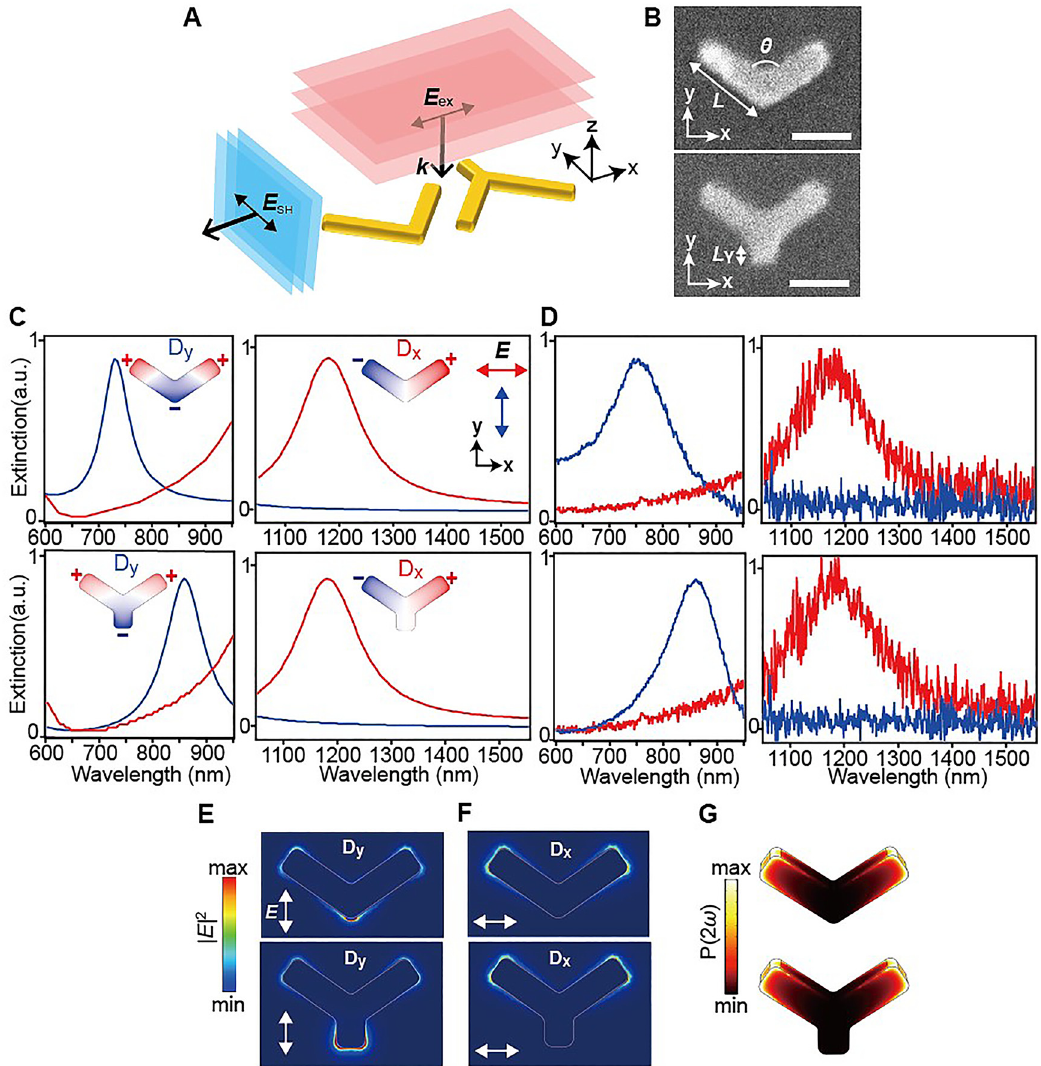
Figure 1: Characteristics of V- and Y-shaped elements in a directional second-harmonic (SH) gold nanoantenna. (A) Unidirectional SH emission from a nanoantenna. (B) SEM images of the V- and Y-elements with arm length L = 140 nm, opening angle L θ = 110 ° , and tail length L Y = 30 nm ( Y = 0 for the V-element). The scale bar is 100 nm. (C and D) Calculated and measured extinction spectra, respectively, of the individual elements in (B) under x -(red) and y -(blue) polarized illuminations. The insets show the phase distributions D x and D y of the plasmon modes oriented along the x - and y -polarizations, respectively. The D x bands of the both elements are almost identical, but the D y resonance wavelength is longer in the Y-element than in the V-element. (E and F) Calculated near- fi eld intensity distributions of the D y and D x modes, respectively, of the V- and Y-elements. (G) Calculated spatial distributions of the surface SH polarization induced by the D x near- fi elds in